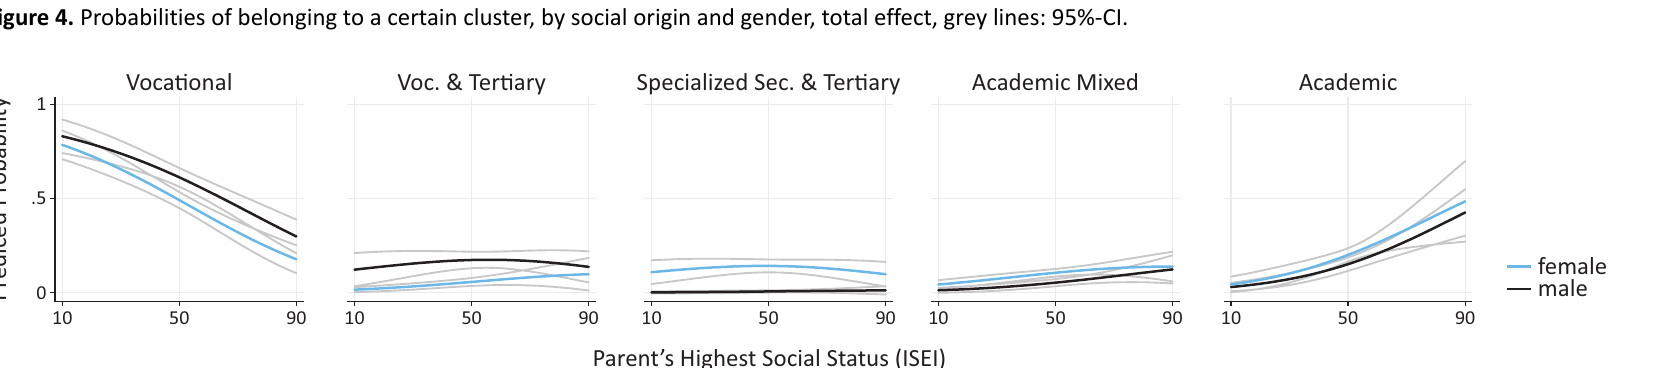
Figure 5. Probabilities of belonging to a certain cluster, by social origin and gender, direct effect, net of reading and mathematics/science skills, grey lines: